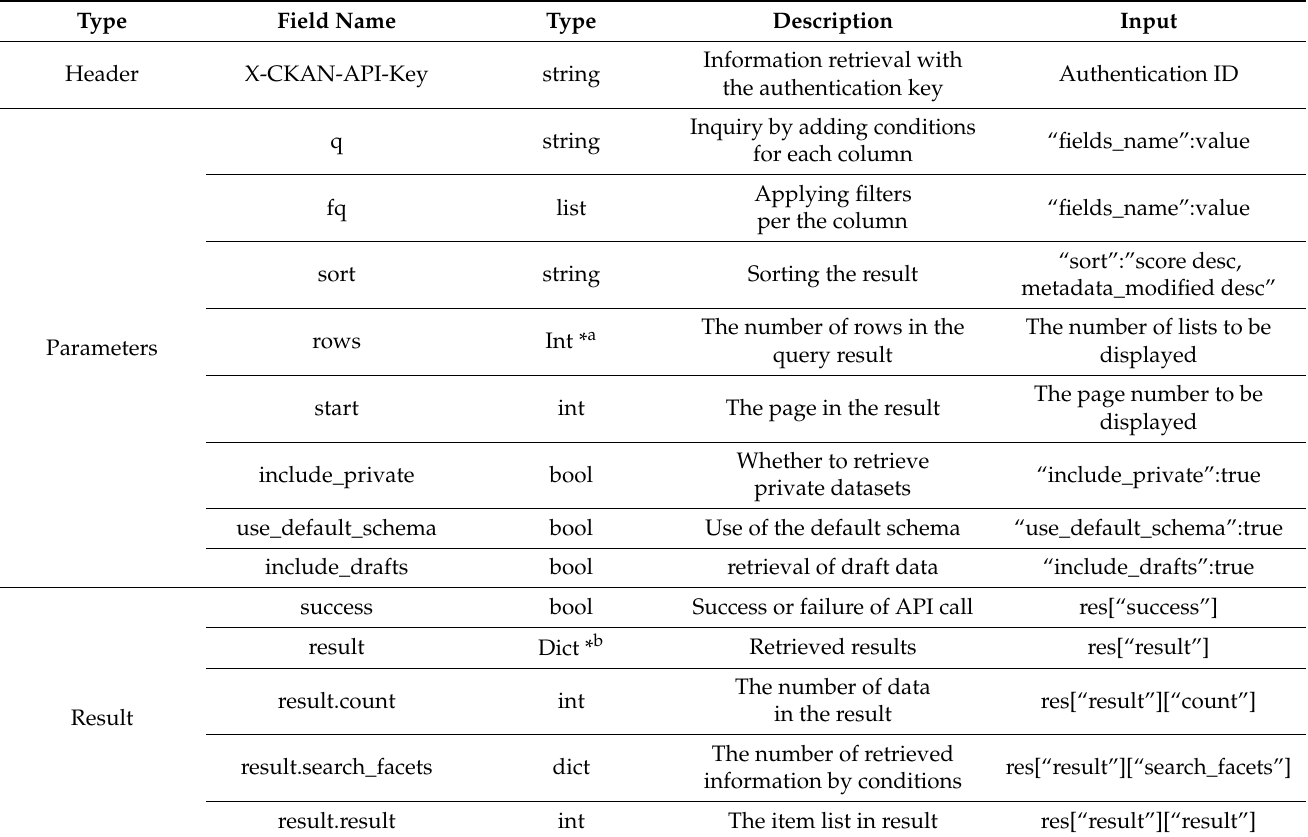
Table 1. Example of an API for product